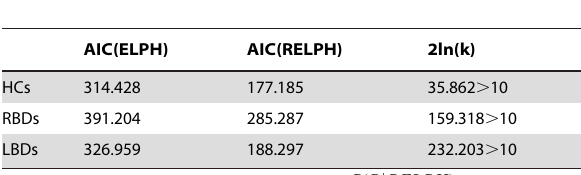
Table 1. AIC value and Bayes factor computed for each model (ELPH and RELPH) per each group